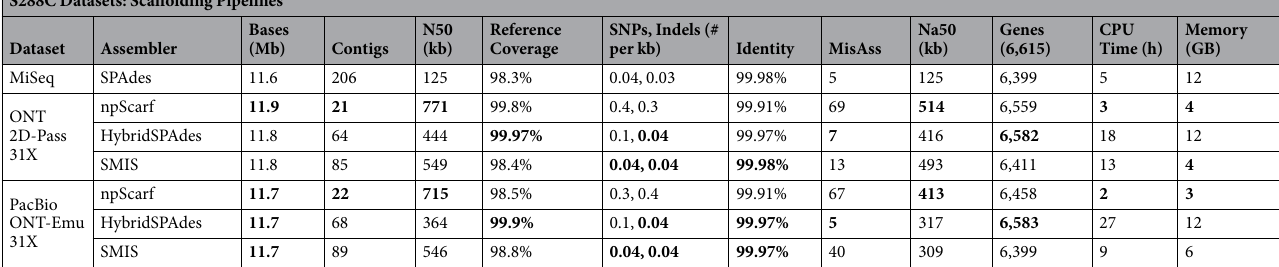
Table 5. MiSeq-only assembly from SPAdes in top row. MiSeq-only assembly from SPAdes scaffolded by the npScarf, HybridSPAdes and SMIS pipelines using the ‘2D-Pass 31X’ ONT sample (Middle) and the ‘ONT-Emu 31X’ PacBio subset (Bottom).